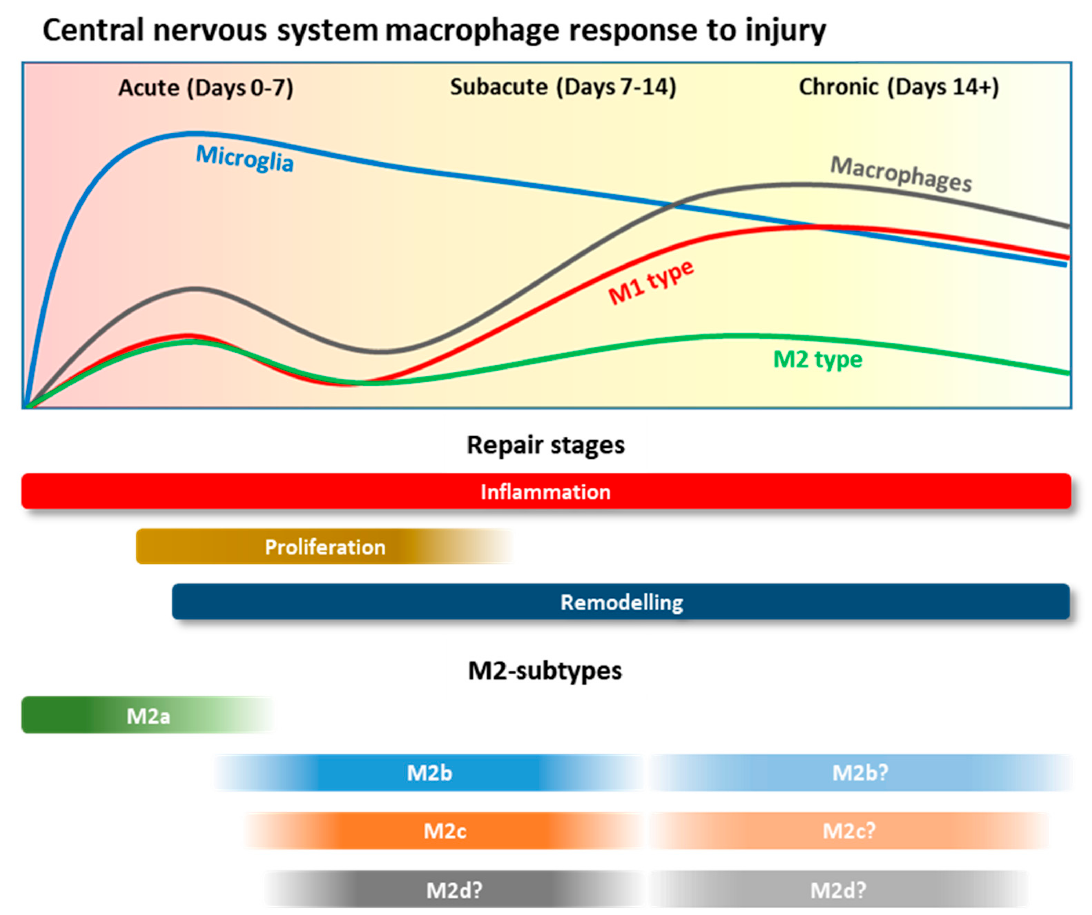
Figure 3. Temporal changes in macrophage phenotype during CNS injury and repair. Timelines for cell infiltration, repair stages and M2 phenotype transition in the wound site were obtained from the following sources.